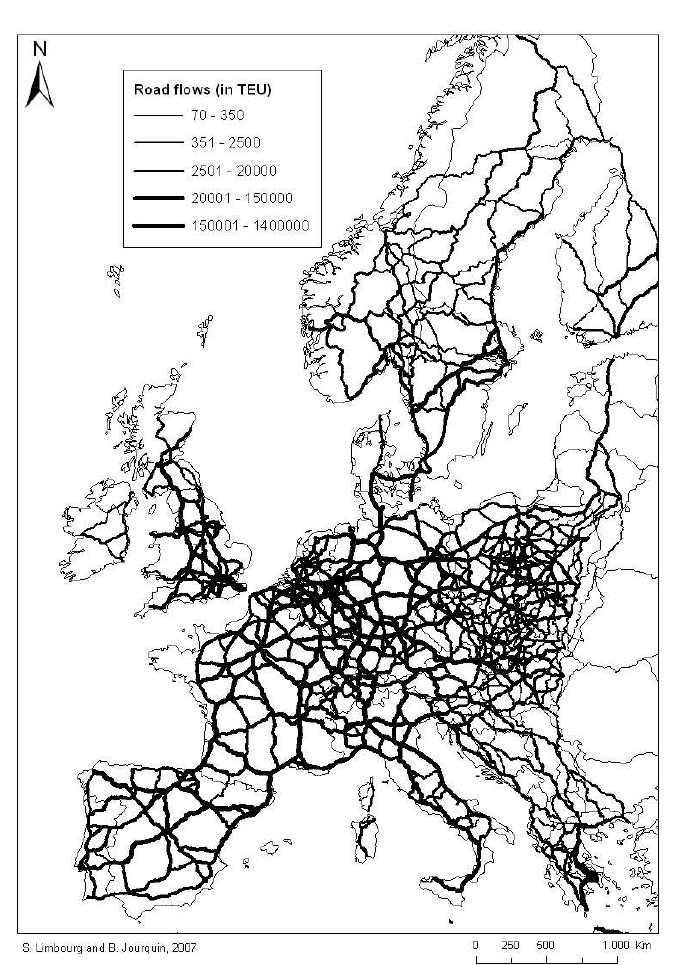
Figure 10. All or Nothing assignment for NSTR chapter 9 over more than 300